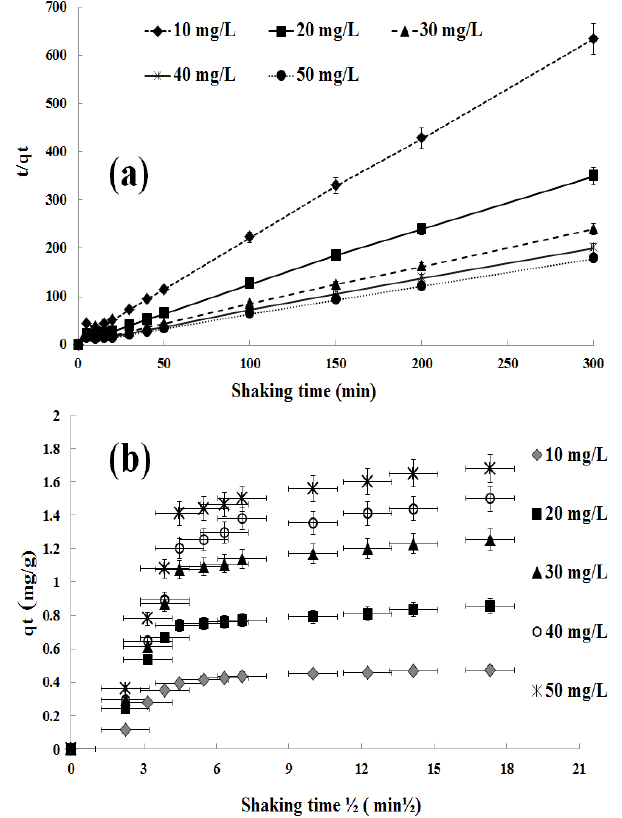
Fig. 5. (a) Pseudo second order kinetic model, and (b) intraparticle diffusion for mercury ions adsorption on Ghezeljeh nanoclay.